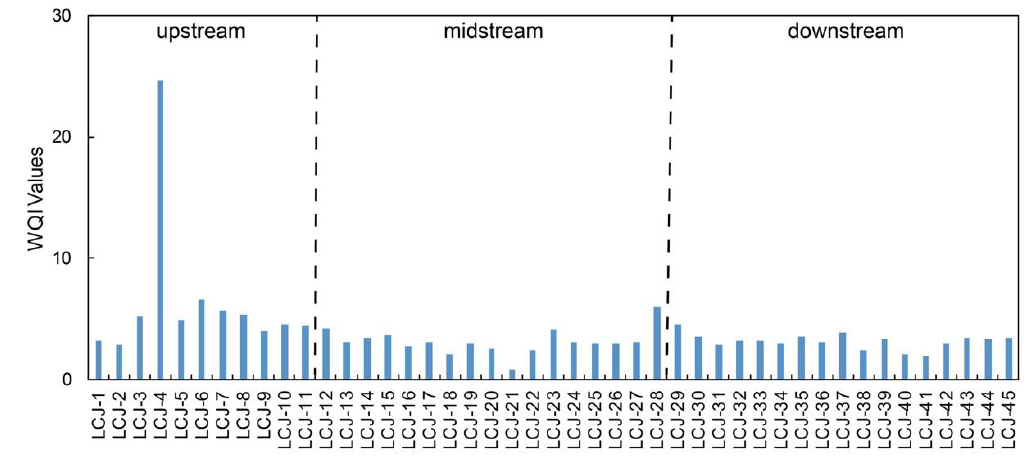
Figure 4. The water quality index for the water samples in the Lancangjiang River. Table 5. Weights for the dissolved heavy metals in the Lancangjiang River.